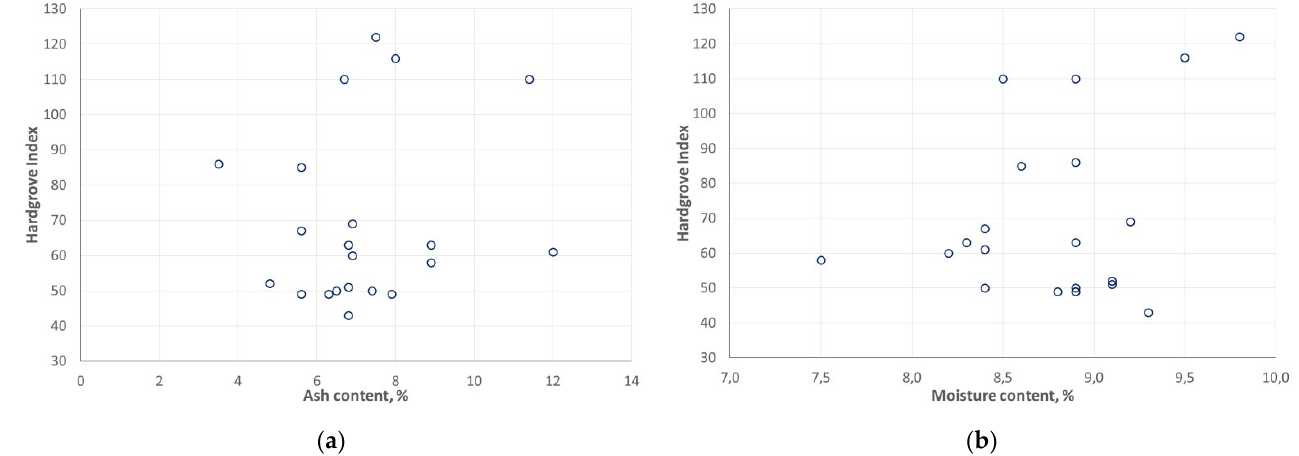
Figure 3. Comparison of Hardgrove index values calculated based on PN-ISO 5074 and PN-G- 04530 standards.